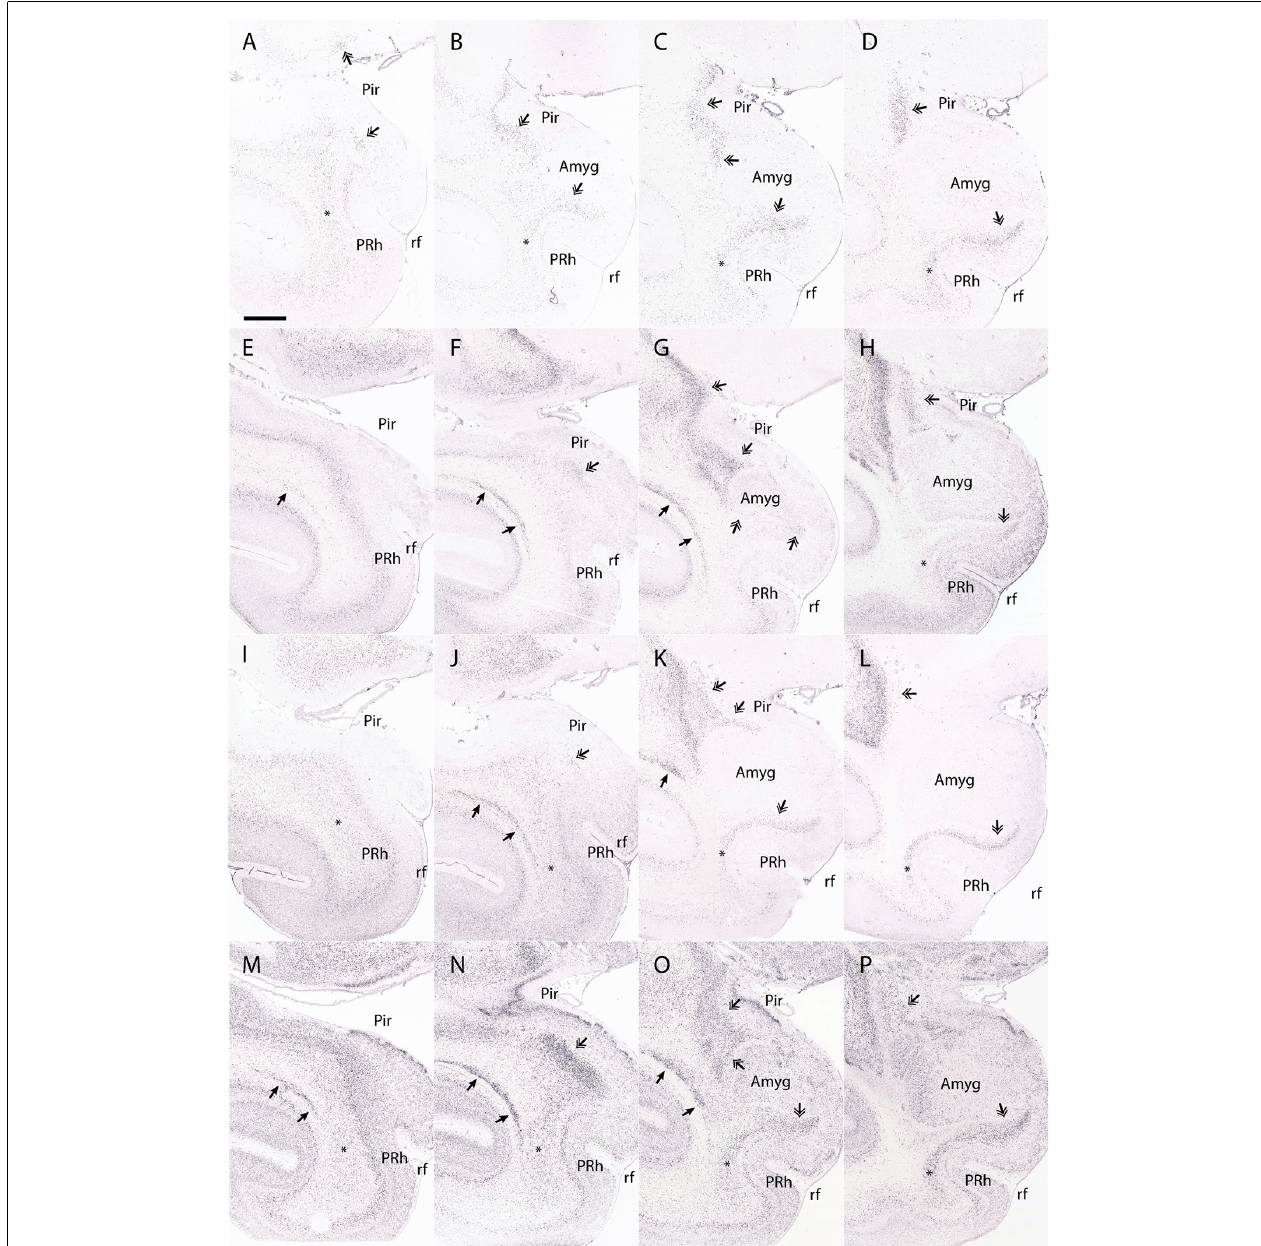
FIGURE 7 | The dorsal endopiriform nucleus (DEn) in the macaque. This figure shows the expression of Ctgf ( A–D) , Ntng2 (E–H) , Nr4a2 (I–L) , and Synpr (M–P) in the macaque DEn. Note that a coronal section through the temporal cortex may contain entorhinal cortex at the medial surface next to the rhinal fissure, yet may contain periamygdaloid olfactory cortex in a more dorsal location, making it difficult to accurately identify the transition between each area. Ctgf expression is seen in the DEn deep to the piriform cortex ( A–D , double arrowhead). The DEn has a caudal part that is topologically inferior to the perirhinal cortex (in this case, medial to the perirhinal cortex) and continues until the periamygdaloid olfactory cortex transitions into the entorhinal cortex ( D , double arrowhead). However, while Ctgf is useful for identifying the DEn, it also labels the subplate, and so other claustral markers must be interrogated to accurately separate the dorsal endopiriform and subplate from the claustral components. For example, Ntng2 expression strongly labels the principal claustrum ( E–G , single arrowhead), although only weak expression is seen in the topologically caudal claustrum that is found deep of the perirhinal cortex ( H , asterisk). The DEn is also strongly labeled ( E–H , double arrowhead). Nr4a2 expression clearly shows the caudal aspects of the dorsal claustrum that lie deep to the perirhinal cortex ( I–L , asterisk). The DEn is also labeled ( J–L , double arrowheads), and maintains a topologically accurate location, deep to the piriform cortex and periamygdaloid olfactory cortex. Synpr expression is present in the DEn ( M–P , double arrowhead), particularly the topologically caudal aspects that lie deep to the periamygdaloid olfactory cortex ( P , double arrowhead). Symbols and abbreviations: Amyg—amygdala; Pir—piriform cortex; PRh, perirhinal cortex; rf—rhinal fissure; single arrowhead—dorsal claustrum; double arrowhead—dorsal endopiriform nucleus; asterisk—topologically caudal claustrum. Scale bar - 8,400 µ m. Images (A–P) © 2009 Allen Institute for Brain Science. NIH Blueprint NHP Atlas (2009). Available online at: blueprintnhpatlas.org.